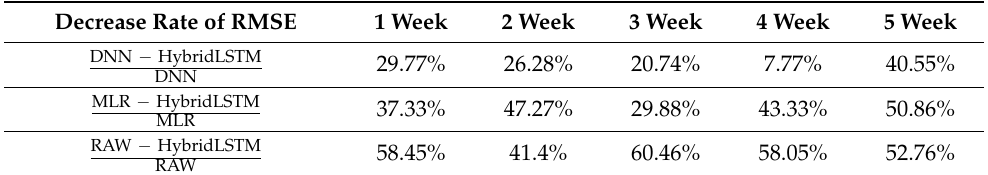
Figure 7. Results of error comparison of HybridLSTM, benchmark and raw data at 1-week intervals based on the aforementioned test set. The error (RMSE) was calculated based on gold standard device (TEOM). We tested the calibration performance using datasets collected at weekly intervals. A total of five sections were used (1, 2, 3, 4 and 5 weeks). Table 3. Results of comparison of calibration results of HybridLSTM with benchmark (MLR) and a low-cost sensor (RAW). DNN, MLR and raw data were evaluated based on HybridLSTM. The decrease rate of RMSE from each of models was calculated.